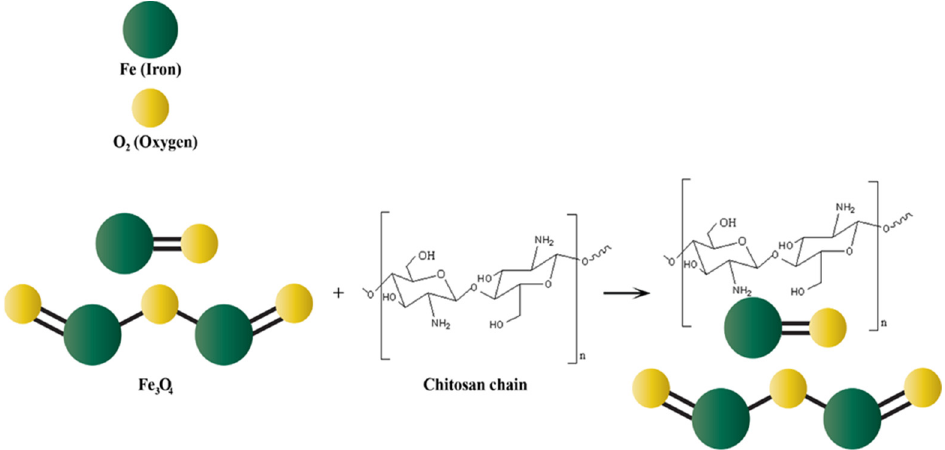
Figure 7. Interaction between the chitosan chain and the magnetic particles.